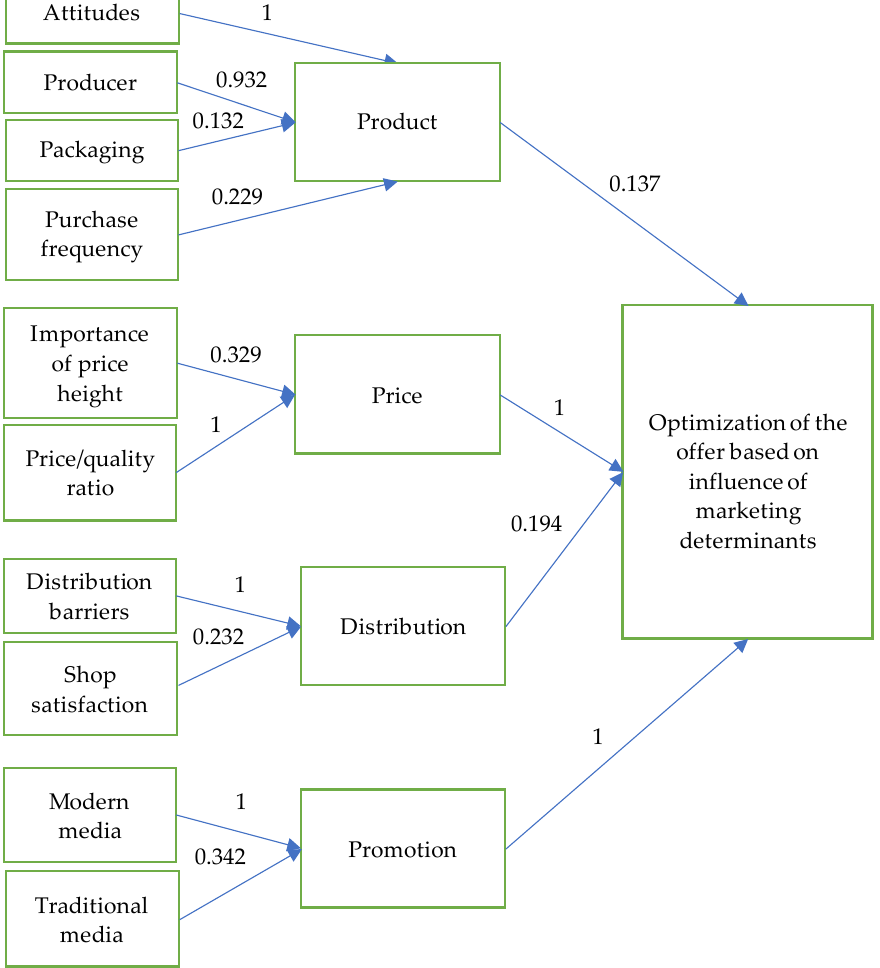
Figure 2. Structural equation modeling results.